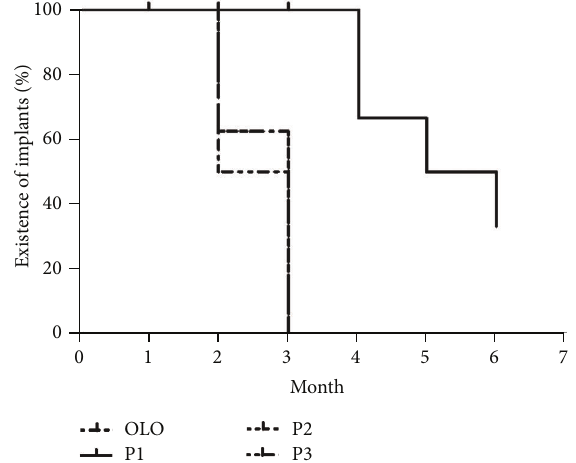
Figure 7: The Kaplan-Meier chart of complete resorption time between the Ologen group and PTLGA terpolymer groups. There were no significant differences of the curves between those groups (log rank test, 𝑃 = 0.051